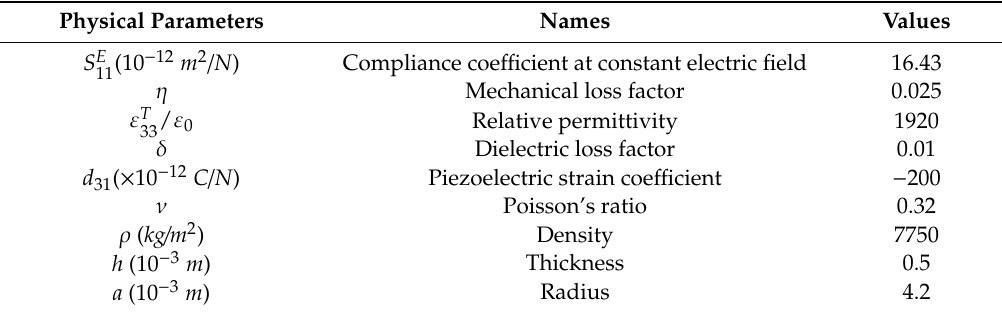
Table 2. Typical parameters of circular piezoelectric sensors (PZT).